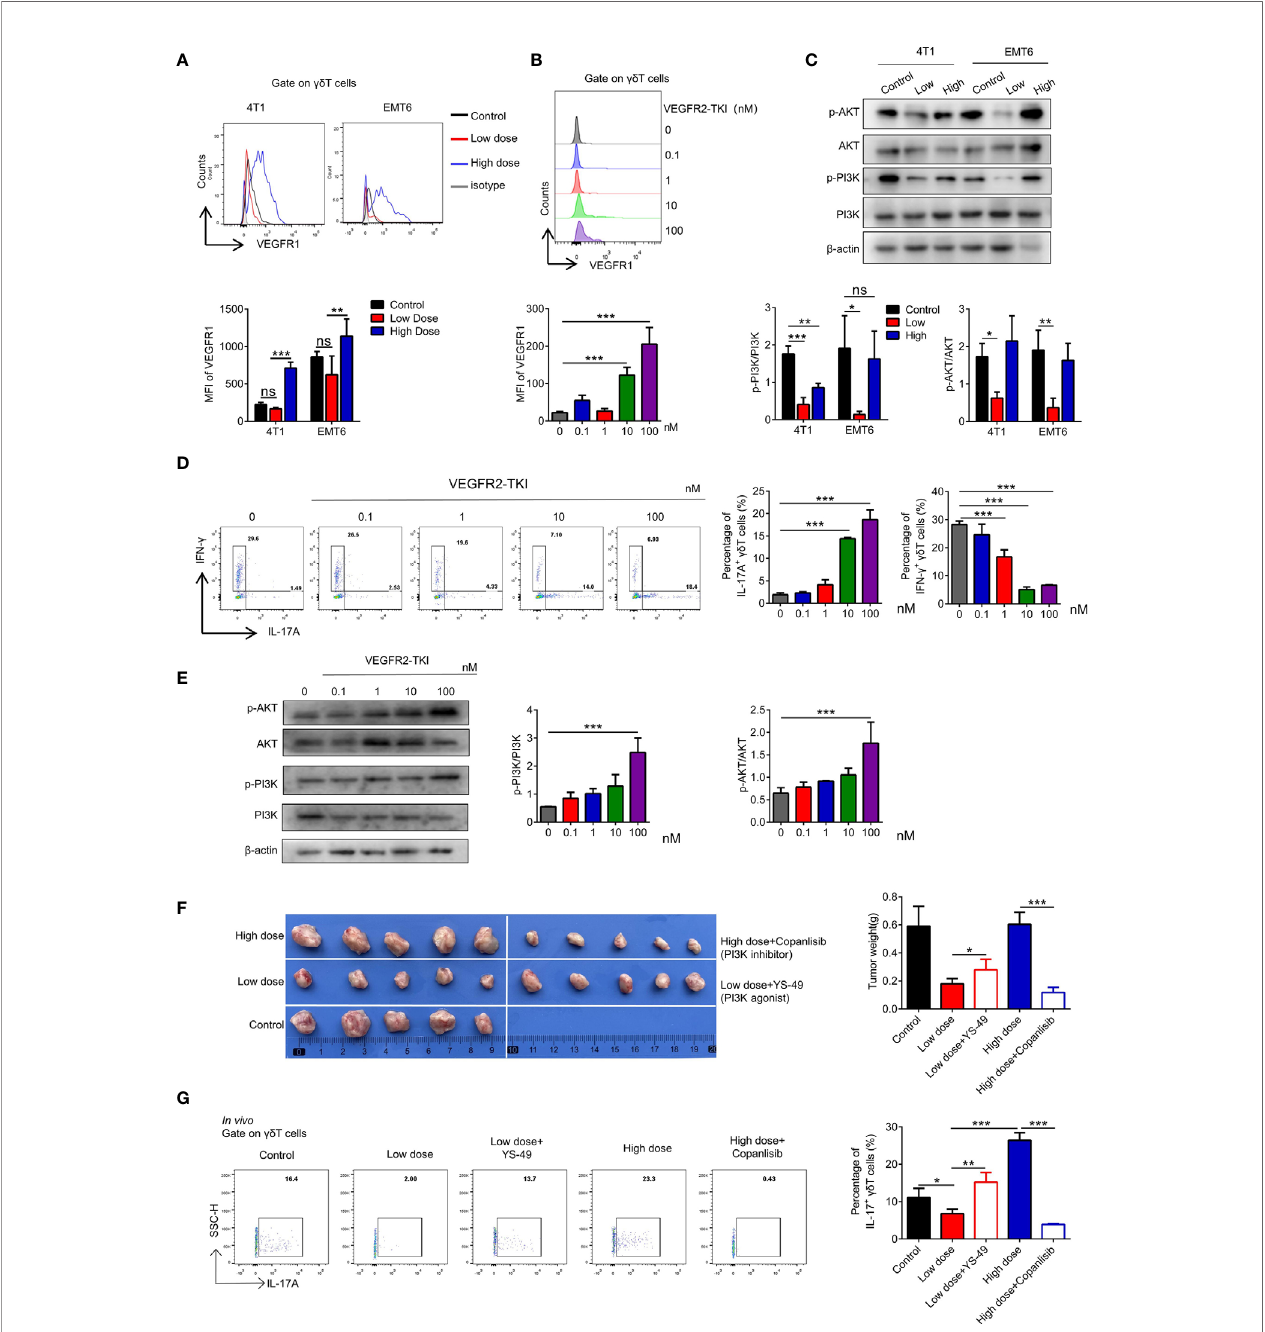
FIGURE 3 | High-dose VEGFR2-TKI therapy induce gd T cells producing IL17A via VEGFR1-PI3K-AKT pathway. (A) Flow cytometry analysis of VEGFR1 expression of gd T cells (CD45 + CD3 + TCR gd + ) in the tumor. (B) Flow cytometry analysis of VEGFR1 expression of gd T cells derived from naive spleen treated with different doses of VEGFR2-TKI in vitro . (C) Western blot analysis of the PI3K and AKT pathways in gd T cells from tumors with different dose of VEGFR2-TKI therapy ( gd T cells were sorted from 4 tumors as one donor). (D) Flow cytometry analysis of intracellular IFN- g and IL17A expression of gd T cells derived from naive spleens treated with different doses of VEGFR2-TKI in vitro . (E) Western blot analysis of PI3K and AKT pathways in gd T cells derived from naive spleens treated with different doses of VEGFR2-TKI in vitro ( gd T cells were sorted from 9 naive spleens as one donor). (F) Representative size of primary tumor after different dose VEGFR2-TKI therapy combined with PI3K agonist or inhibitor in vivo (n=5). (G) Intracellular IL17A expression of gd T cells from tumors after different dose VEGFR2-TKI therapy combined with PI3K agonist or inhibitor in vivo (n=5). Data are presented as the means ± SD from one representative experiment. Similar results were obtained from three independent experiments, n=4 mice each group, unless indicated otherwise. Statistical analysis was performed by one-way ANOVA. ns, not signi fi cant, *p < 0.05, **p < 0.01, and ***p < 0.001. See also Supplementary Figure S3